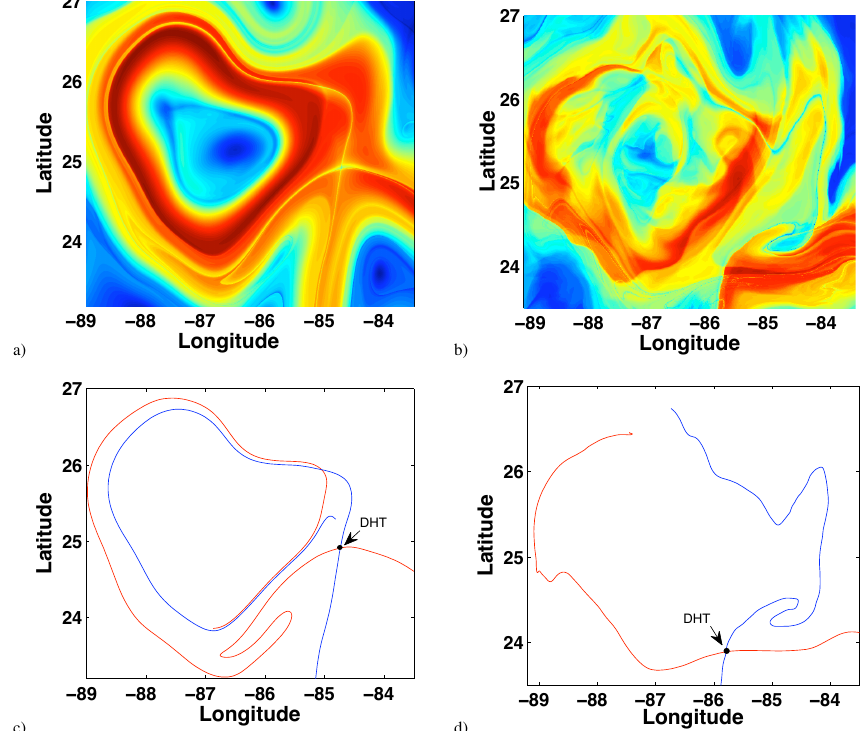
Fig. 3. Evaluation of the M function and visualization of the manifold structure on the 12th June 2010 at 12:00H. a) Evaluation of M with AVISO for τ = 15 days; b) M on HYCOM for τ = 9 days; c) manifolds with AVISO computed for 15 days; d) manifolds with HYCOM computed for 9 days.